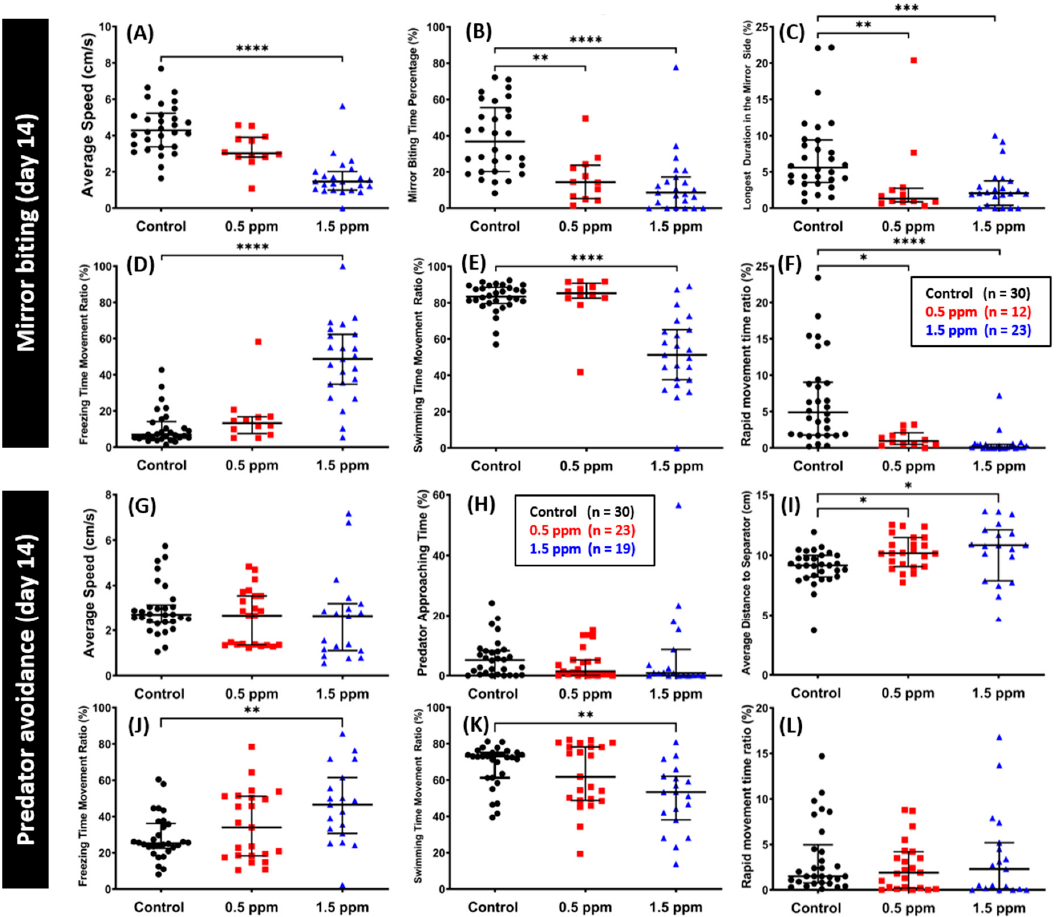
Figure 3. Comparison of mirror biting and predator avoidance behavior endpoints between the untreated control and C 70 -exposed fish after 14-day exposure. ( A ) Average speed, ( B ) mirror biting time percentage, ( C ) longest duration in the mirror side, ( D ) freezing time movement ratio, ( E ) swimming time movement ratio, and ( F ) rapid movement time ratio were analyzed for the mirror biting assay ( n = 30 for the untreated control; n = 12 for the 0.5 ppm C 70 NP-exposed fish; n = 23 for the 1.5 ppm C 70 NP-exposed fish). For predator avoidance test, the ( G ) average speed, ( H ) predator approaching time ratio, ( I ) average distance to separator, ( J ) freezing time movement ratio, ( K ) swimming time movement ratio, and ( L ) rapid movement time ratio were analyzed ( n = 30 for the untreated control; n = 23 for the 0.5 ppm C 70 NP-exposed fish; n = 19 for the 1.5 ppm C 70 NP-exposed fish). The data are expressed as the median with interquartile range and were analyzed by the Kruskal–Wallis test continued with Dunn’s multiple comparisons test as a follow- up test (* p < 0.05, ** p < 0.01, *** p < 0.001, **** p < 0.0001).